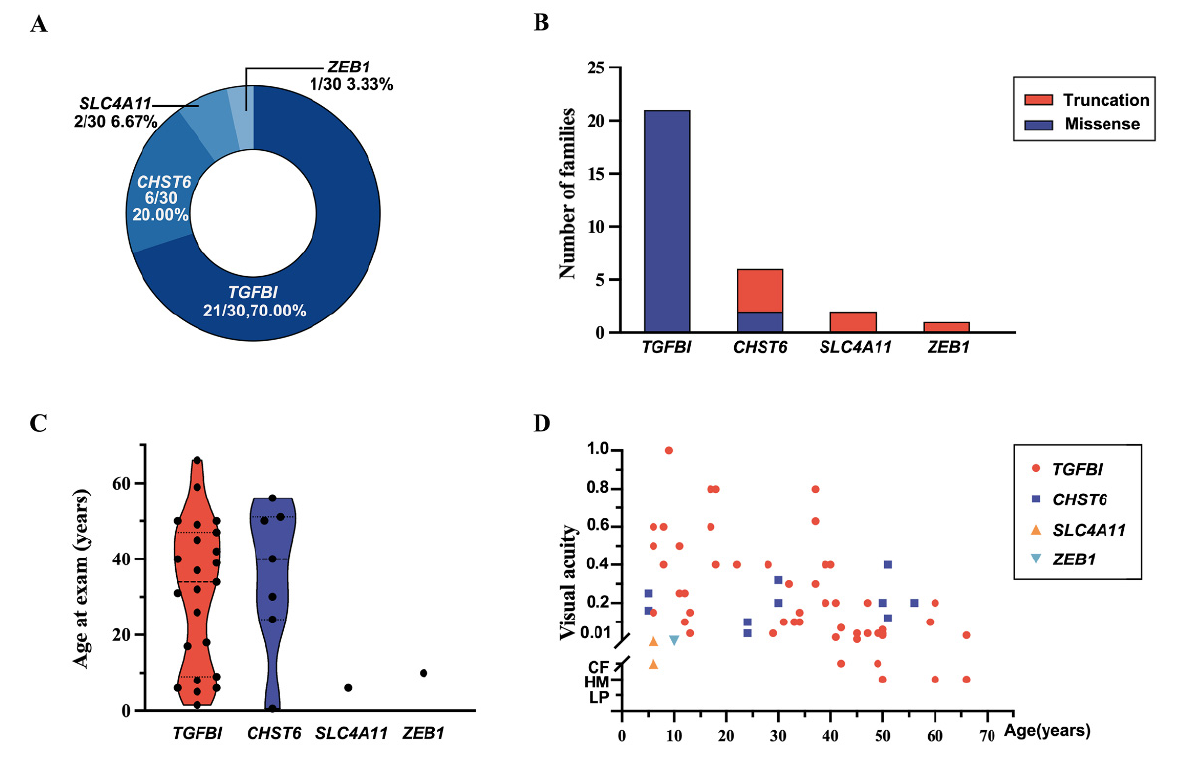
Figure 2. Genetic and clinical features of in-house families of CDs. ( A ) Proportion of in-house families with pathogenic or likely pathogenic variants in TGFBI , CHST6 , SLC4A11 , or ZEB1 . ( B ) Distribution of variant types. Truncation variants include splicing variants, frameshift variants, and nonsense variants. ( C ) Correlation of age at exam with variants in TGFBI , CHST6 , SLC4A11 , and ZEB1 . ( D ) Correlation of visual acuity with age at exam (including data of both eyes and data at follow- up).